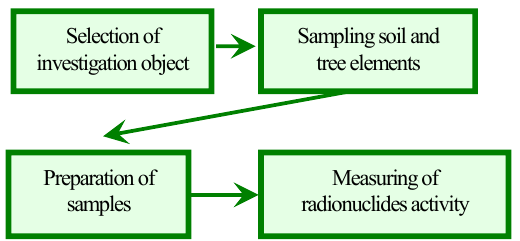
Fig. 1. Scheme of determination of radionuclide transfer from soil to